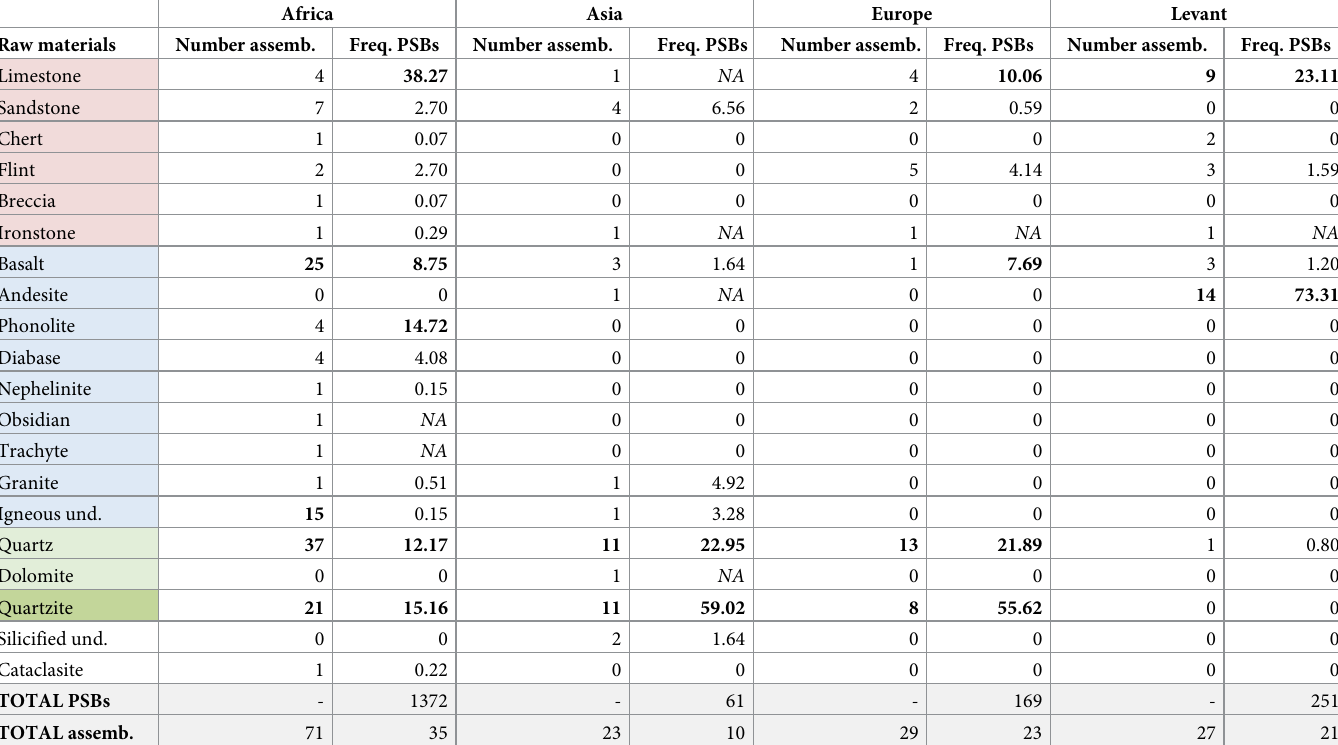
Table 3. Minimum counts of assemblages with at least one PSB in the raw material of interest, and PSB frequencies according to raw materials and